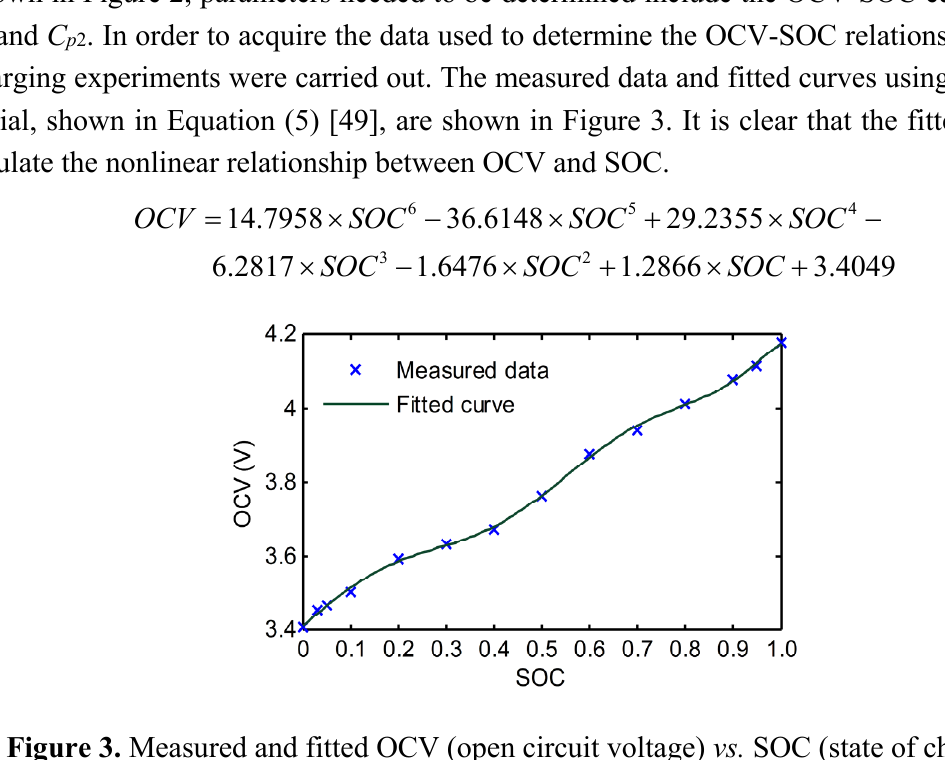
Figure 3. Measured and fitted OCV (open circuit voltage) vs. SOC (state of